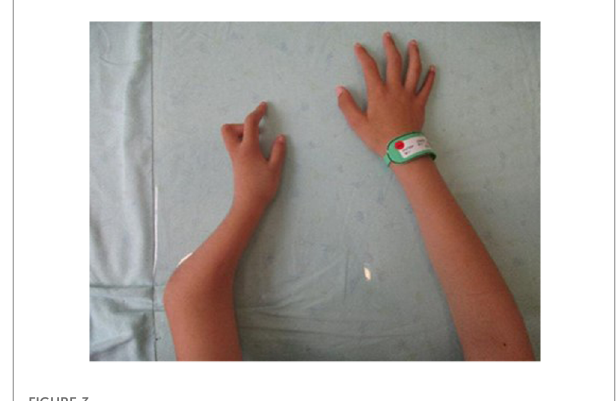
FIGURE 3 Deformity of the left forearm.